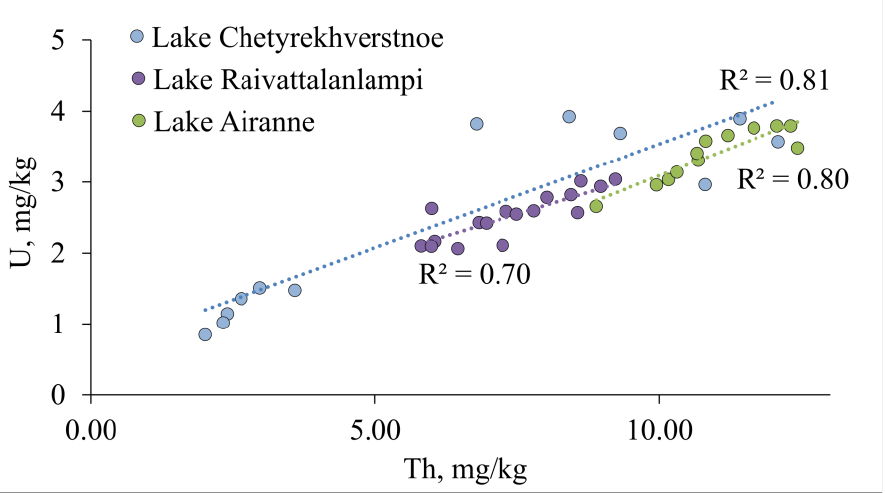
Figure 8. Correlation between the concentration of U and Th in the sediments of some Karelian lakes with high Th content.